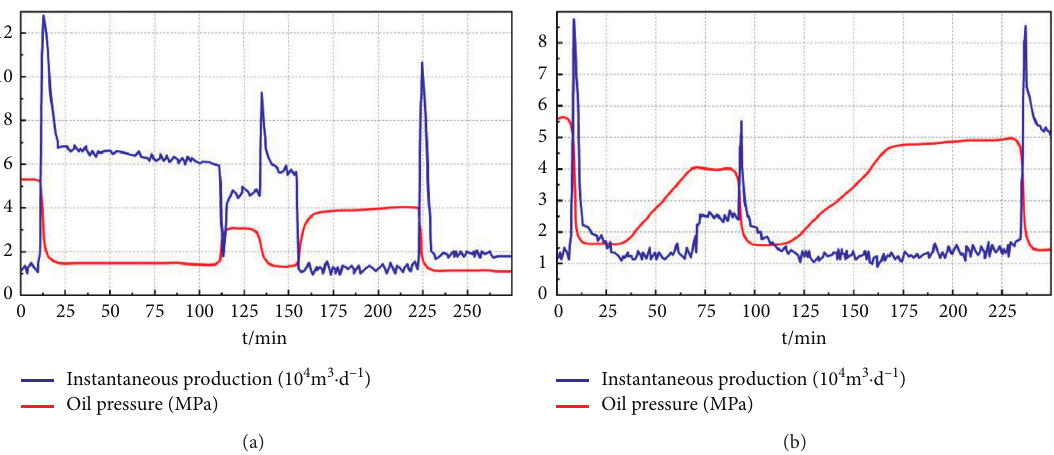
Figure 14: Production regulation pressure waveform and production for 6 successive times. (a) Production regulation process with reducing opening. (b) Production regulation process with increasing opening.